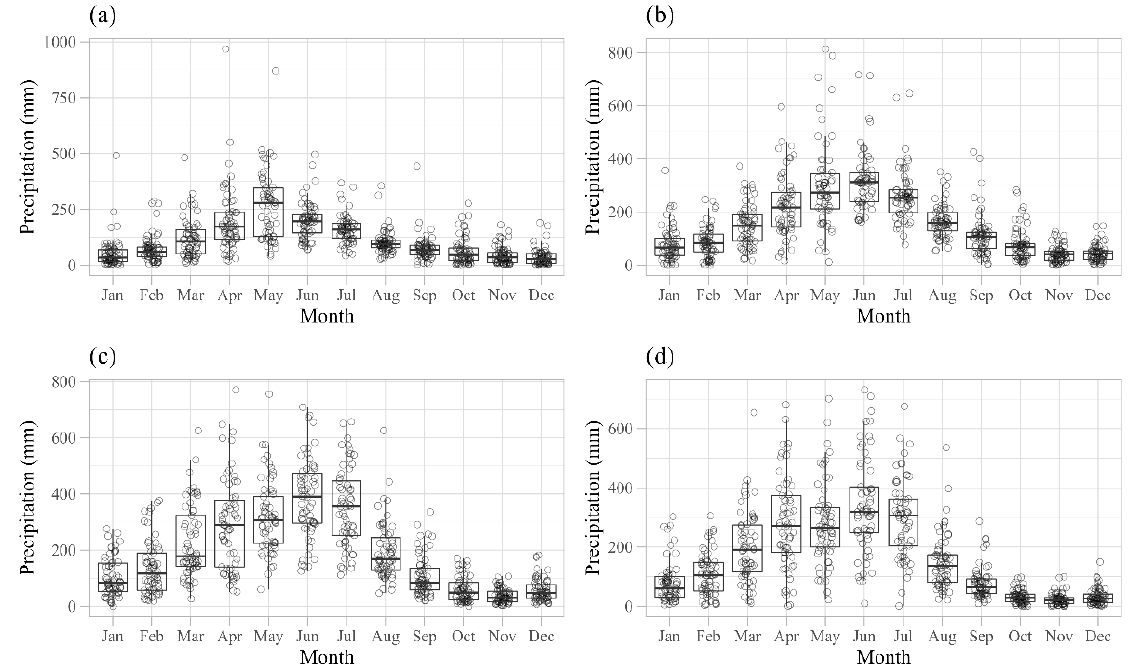
Figure 6. Monthly rainfall boxplot (mm) at ENEB — Aracaju ( a ), Maceió ( b ), Recife ( c ), and João Pessoa ( d ) from 1960 to 2020.